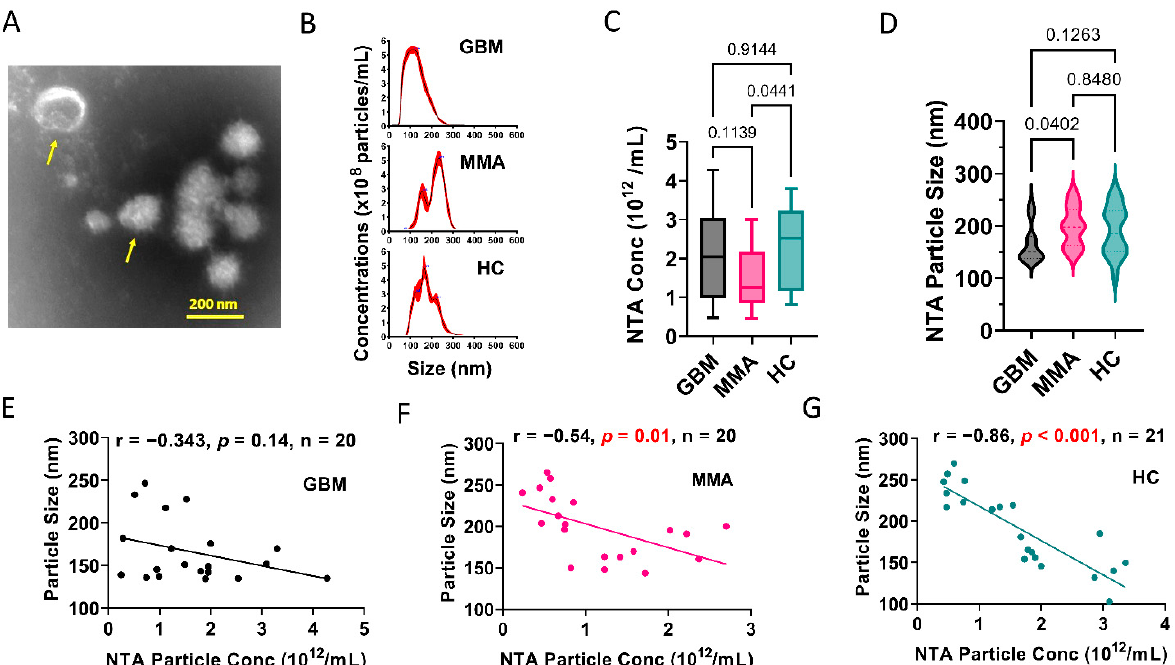
Figure 1. Glioblastoma plasma-derived extracellular vesicles possess unique phenotypes. ( A ). Representative transmission electron microscopic image of EVs derived from pooled GBM plasma. Yellow arrows show typical EVs. The mean size of the GBM EVs is 100–200 nm. ( B ). Nanoparticle Tracking Analysis (NTA) showing representative graphs for EVs purified from plasma of patients with GBM and MMA, and healthy controls (HC). ( C ). Summary of the number of EVs in the plasma of GBM, MMA, and HC, as determined by NTA. MMA EVs showed lower numbers of EVs (n = 20) compared to HC EVs (n = 21). ( D ). GBM plasma EVs are significantly smaller (n = 20) compared to MMA EVs (n = 20). The mean size of GBM EV is 166 nm. ( E – G ). Correlation analysis between NTA particle concentrations and particle sizes. ( E ). No correlation between concentration and size was observed for GBM EVs (r = − 0.343, p = 0.14, n = 20). However, significantly correlated results were seen in MMA EVs (r = − 0.54, p = 0.01, n = 20) ( F ) and HC EVs (r = − 0.86, p < 0.001, n = 21) ( G ).